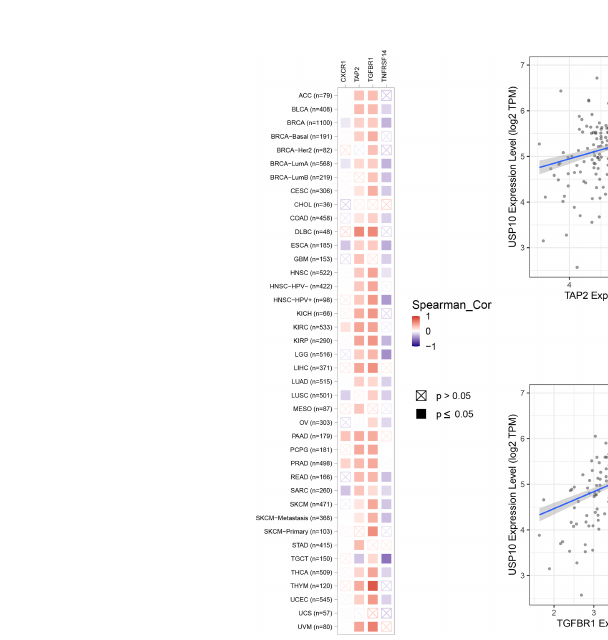
FIGURE 5 USP10 was positively correlated with TAP2 and TGFBR1 in